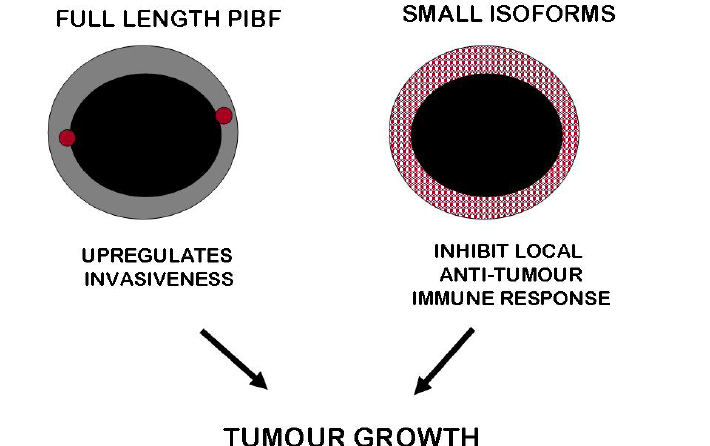
Figure 2. PIBF acts in favor of tumour progression. The full length PIBF is associated with the pericentriolar satellite and upregulates the invasiveness of tumour cells. The smaller isoforms present in the cytoplasm are secreted, and by inducing a Th2 dominant cytokine production as well as reduced NK activity, inhibit local anti-tumour immunity. These together, result in enhanced tumour